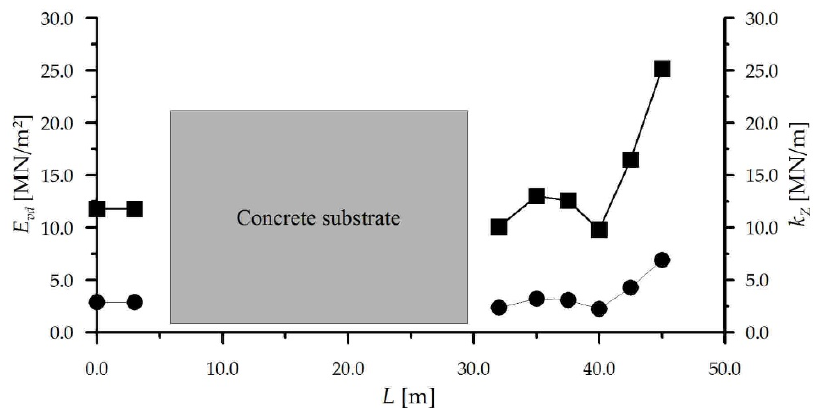
Figure 4. Test results from the lightweight deflectometer ZORN ZFG3000: (cid:4) E vd —dynamic deformation modulus of subsoil, • k Z — stiffness of support, L —distance measured along the scaffolding.